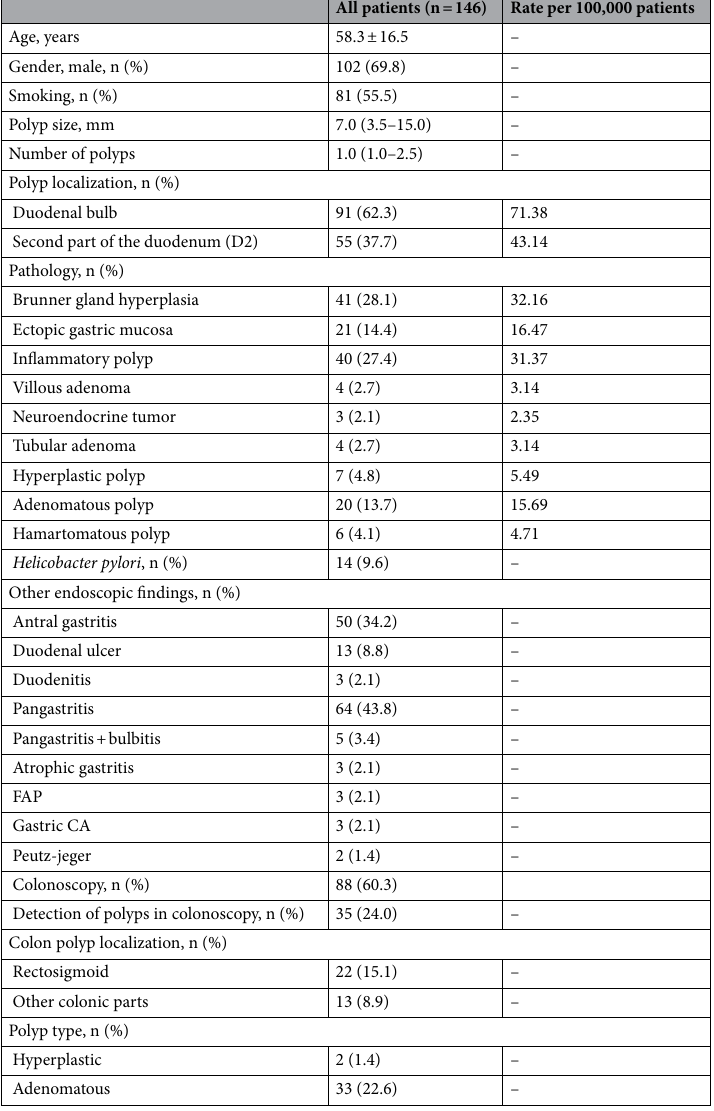
Table 2. Demographic characteristics, endoscopic and colonoscopy findings, and pathological evaluations of patients with duodenal polyps, pathologic findings as rate per 100,000 patients. Data are expressed as median ± SD or median (IQR) or frequency (%). SD standard